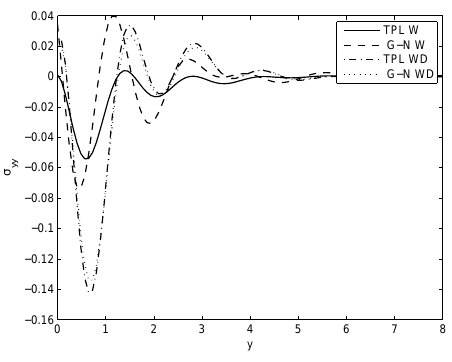
Fig. 3 Distribution the stress function σ yy with and without diffusion.